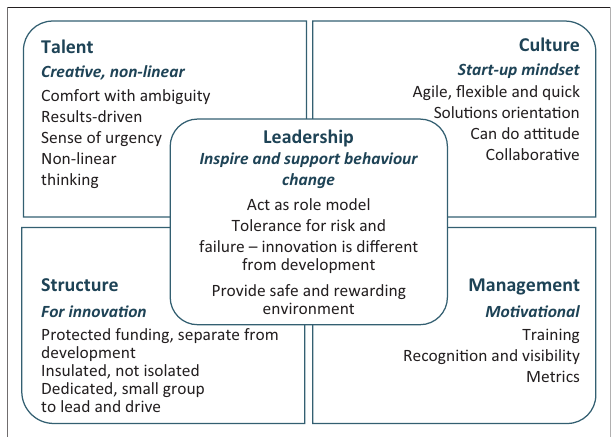
FIGURE 3: Innovation culture (PricewaterhouseCoopers [PwC] Digital